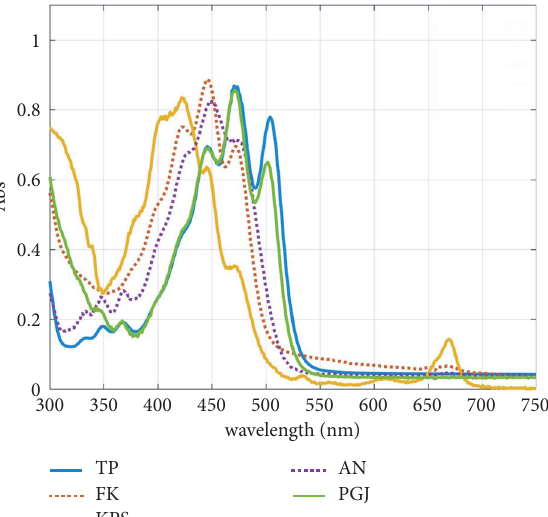
Values bearing different letters for the same parameter are significantly different ( p < 0 . 05). Values in brackets are standard errors ‘TC’ for total carotenoids.